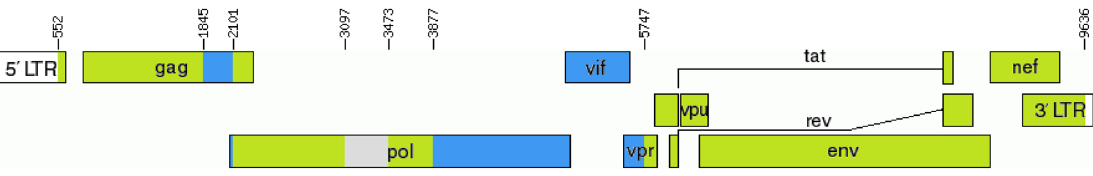
Figure 4. Confirmed structure of the complex recombinant. The confirmed structure of the complex A1/B/D/U recombinant specimen 34567 following maximum likelihood analysis with the CRF50_A1D specimens. CRF50_A1D regions are shown in green and subtype B regions are shown in blue.